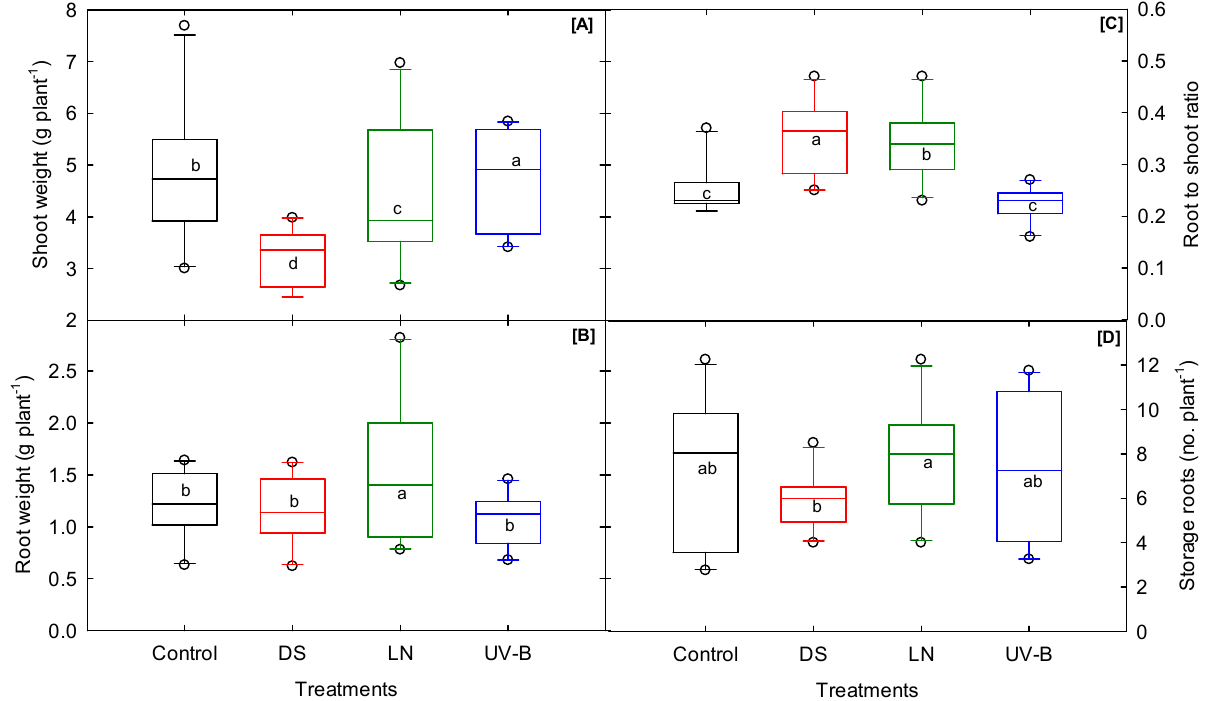
Figure 5. Drought (DS), low nitrogen (LN), and ultraviolet-B (UV-B) effect on ( A ) shoot weight, ( B ) root weight, ( C ) root to shoot ratio, and ( D ) storage root number of 10 sweet potato cultivars measured at 20 days after planting. The middle line indicates the median, and the box shows the range of the 25th to 75th percentiles of the total data. The different alphabetic letters (a, b, c, and d) labeled within the box represent the significant differences between treatments (Duncan Multiple Range Test, p < 0.05), and the outer dots are